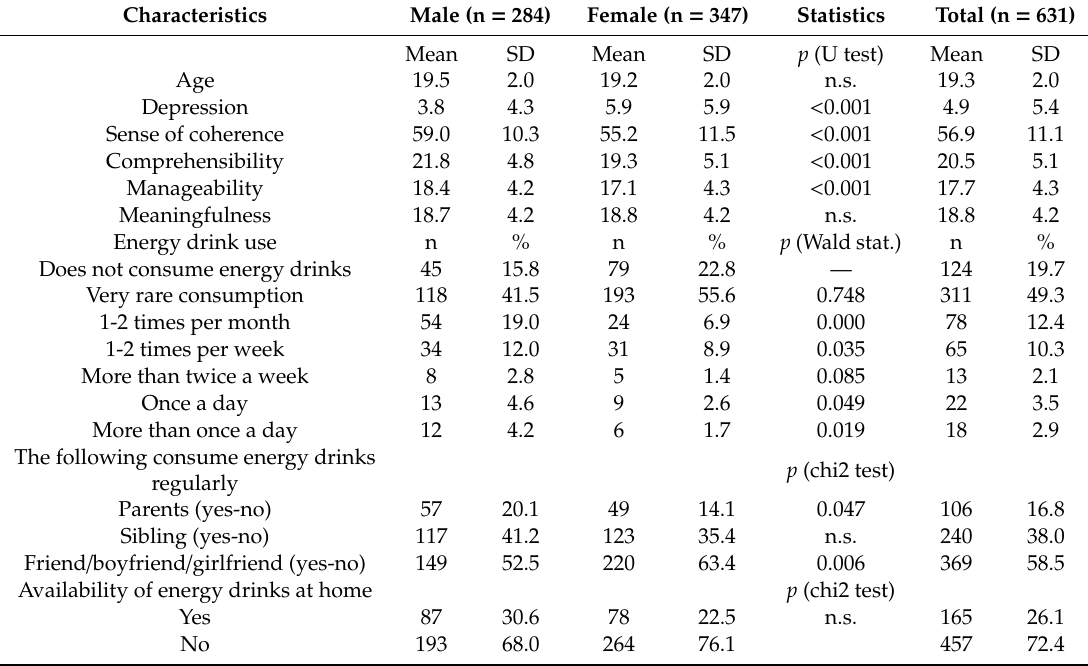
Table 1. Characteristics of the sample according to sex.